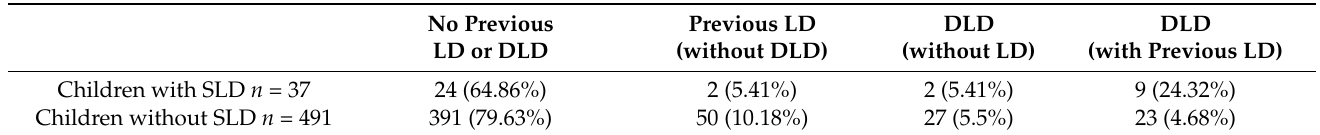
Table 2. Number and percentage of children with and without SLD who had either typical (no previous LD or DLD) or atypical (LD, DLD, or both) language